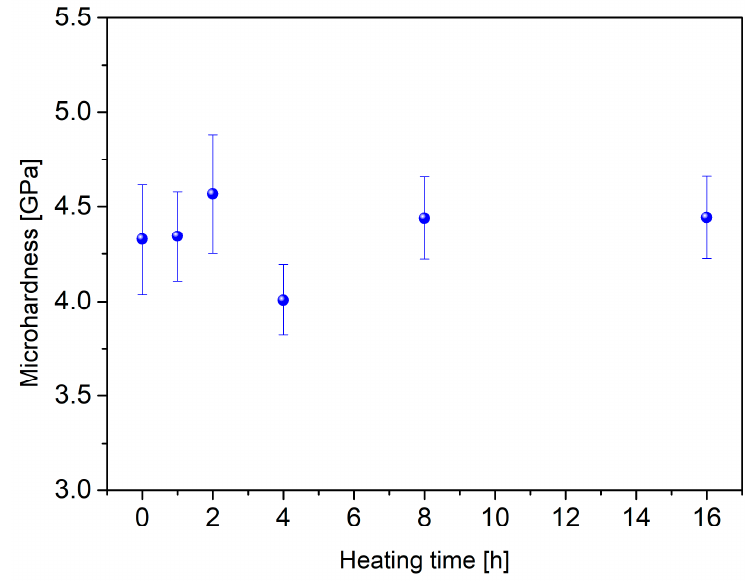
Figure 6. Microhardness values of the heat-treated glass samples.